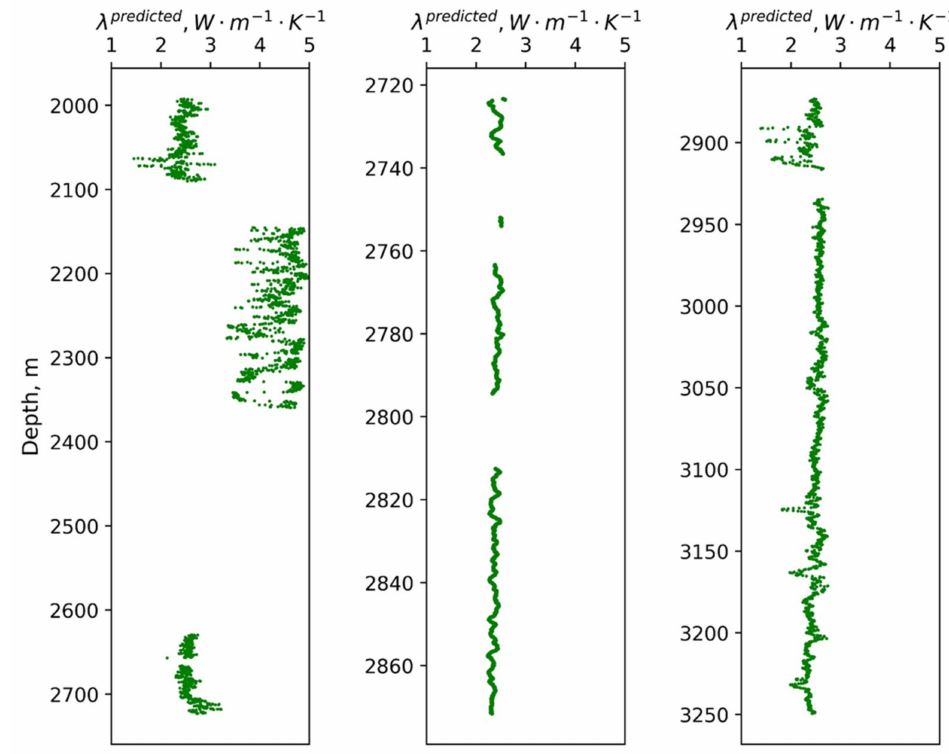
Figure 8. Predicted rock thermal conductivity within non-cored intervals from well-logging data via the established regression